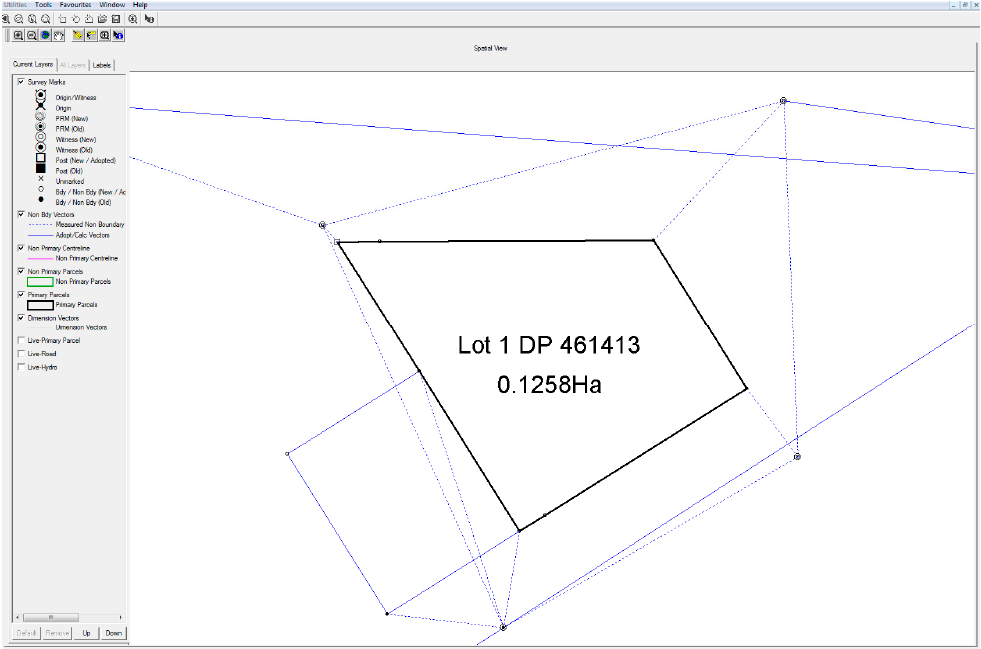
Figure 3. Landonline spatial view of captured cadastral survey dataset.